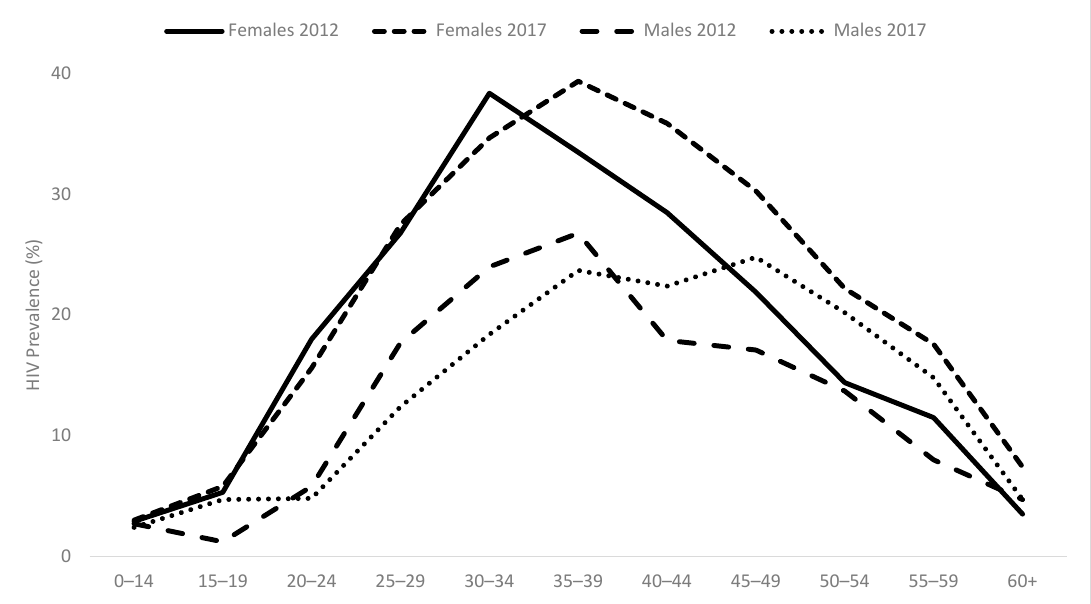
Figure 2. HIV prevalence by age for males and females in South Africa, 2012 and 2017.